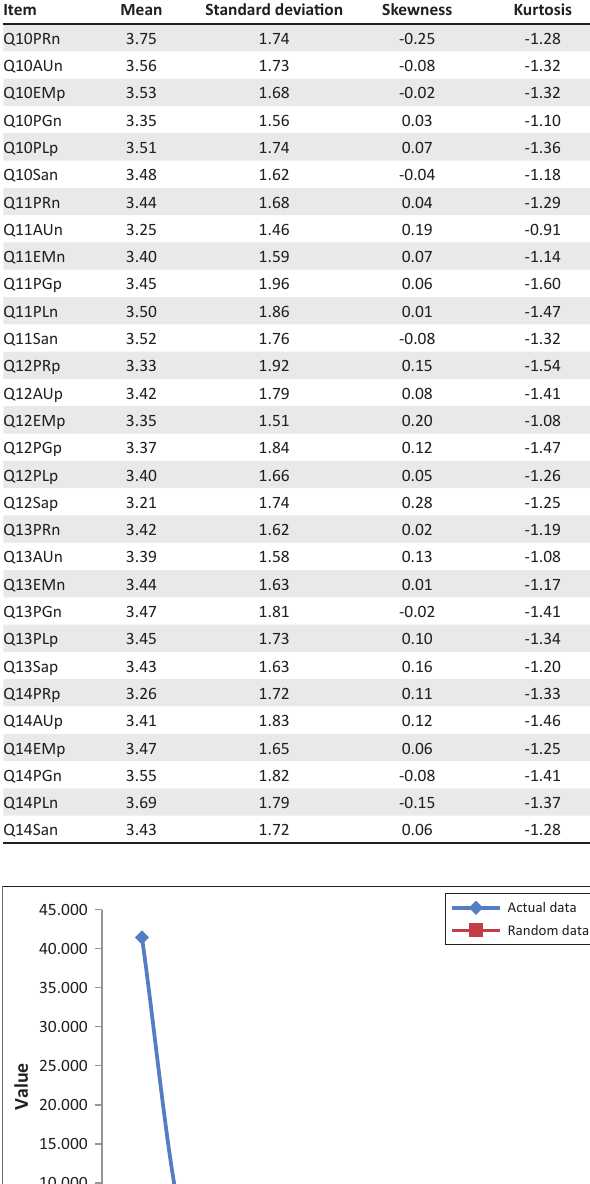
TABLE 1 (Continues...): Descriptive statistics for the Ryff Scales of Psychological Well-Being.